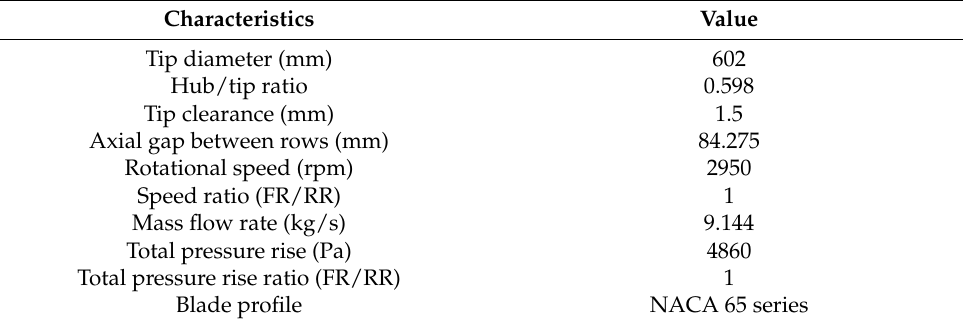
Table 1. The baseline CRF design specification.